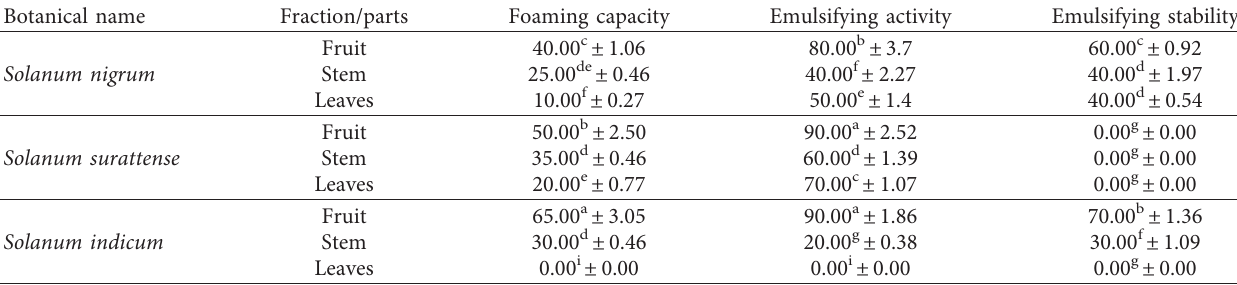
Figure 1: Water-holding capacity (a), oil-holding capacity (b), and foaming stability (c) of extracted hydrocolloid from aerial parts of S. nigrum, S. surattense , and S. indicum using the water extraction method. a–f Different letters on bars show significant difference ( P ≤ 0 . 05). Table 2: Foaming capacity, emulsifying activity, and emulsifying stability (%age ± SD) of hydrocolloid from aerial parts of S. surattense, S nigrum , and S indicum using the water extraction